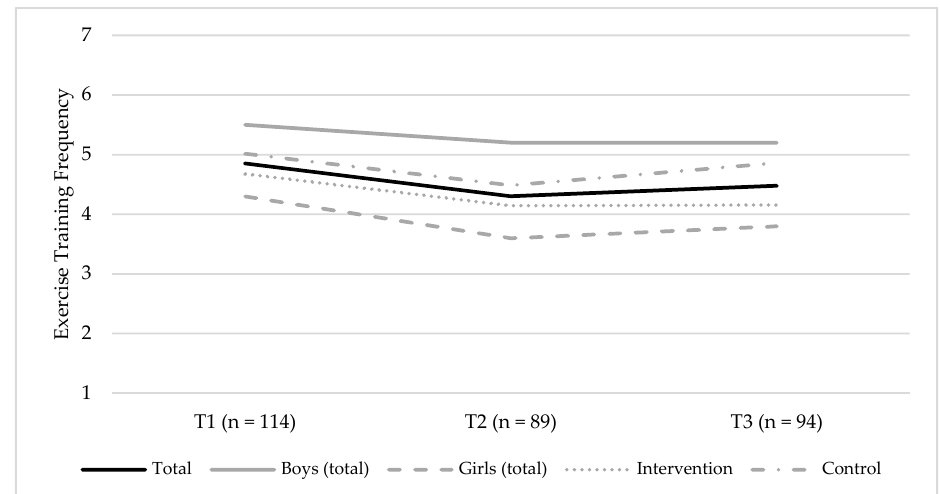
Figure 3. Changes in the self-reported exercise training (ET) frequency between T1 (baseline, 2014) and T3 (endpoint, 2016) for the total sample, boys (total sample) and girls (total sample), and the intervention group and control groups, respectively. The figure shows the mean group levels of ET frequency, and possible responses were coded as follows: 1 = never; 2 = less than once a month; 3 = once a month; 4 = once a week; 5 = 2–3 times a week; 6 = 4–6 times a week; and 7 = every day.